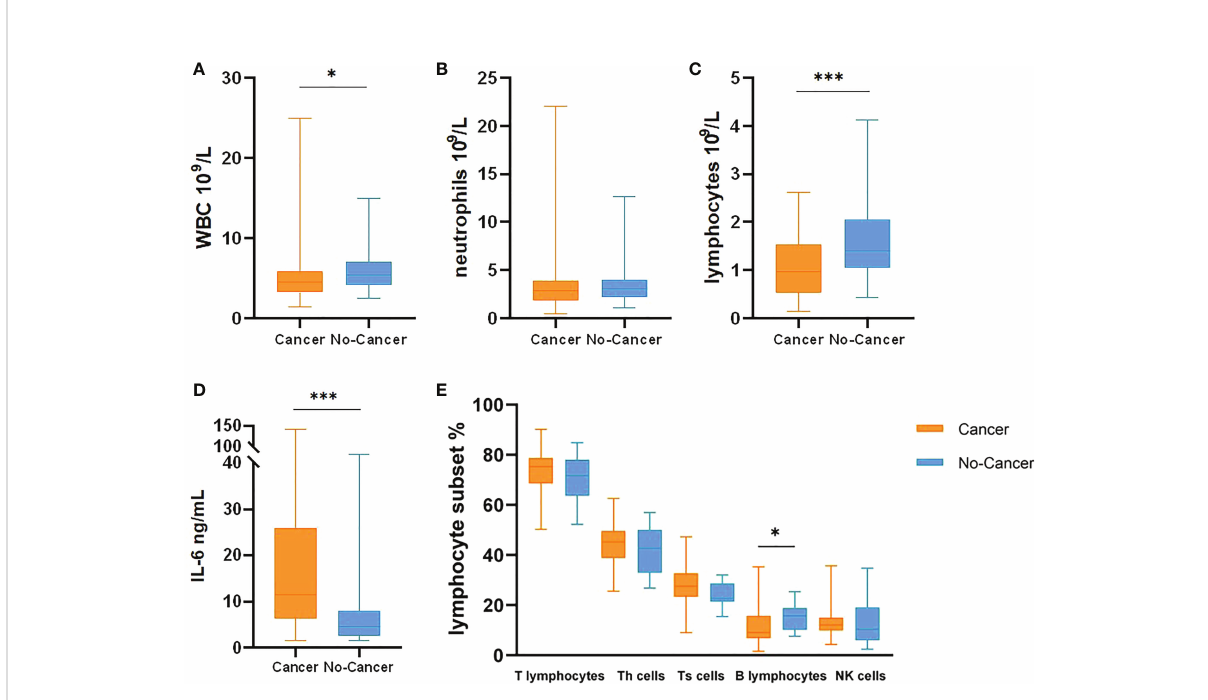
FIGURE 2 Leukocyte, IL-6 and Lymphocyte Subsets comparison between cancer patients with COVID-19 and no-cancer patients ( (A) WBC, (B) neutrophils, (C) lymphocytes, (D) IL-6, (E) Lymphocyte Subsets]. *p < 0.05, ***p <